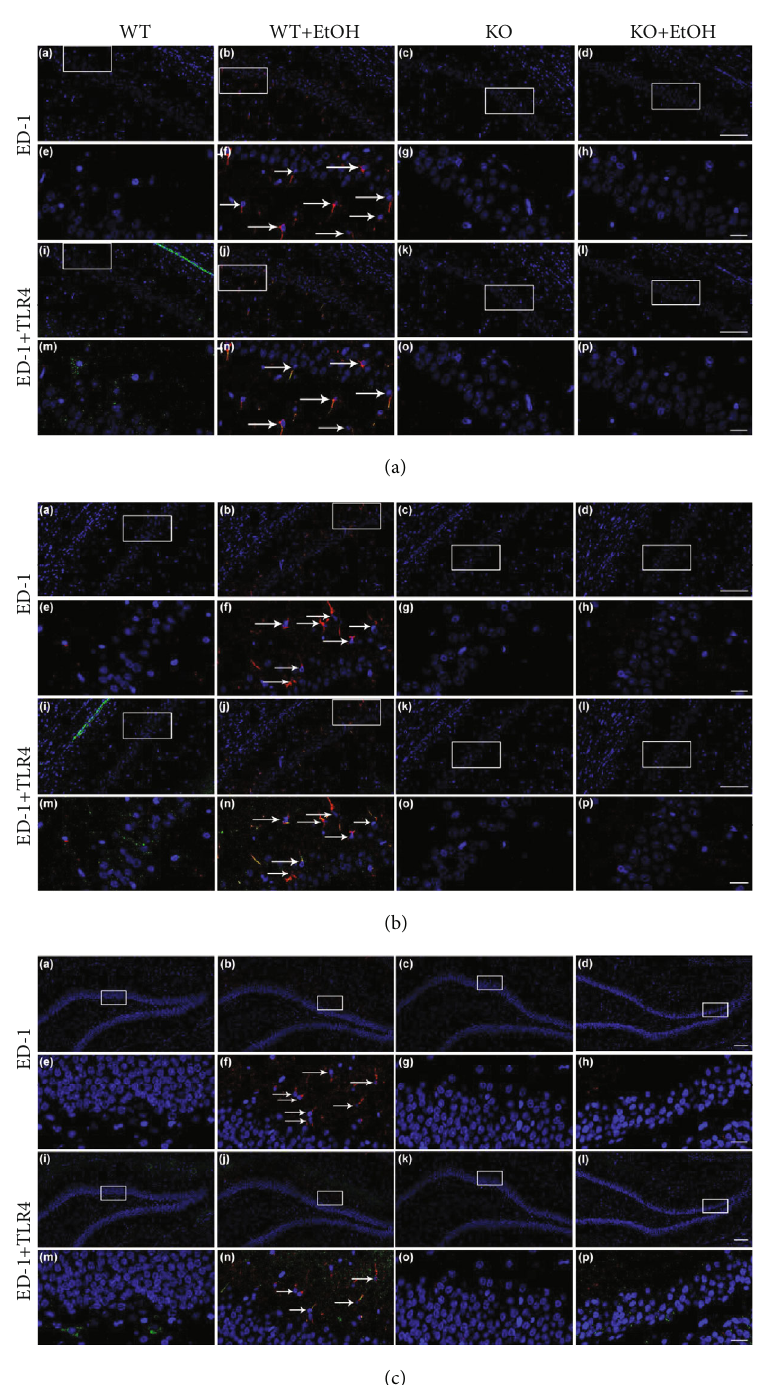
Figure 2: E ff ect of ethanol exposure on the extent of microglial activation (ED-1 staining) and colocalization of ED-1 with TLR4 (ED-1/TLR4 colabeling) in the hippocampus. Representative photomicrographs of level-matched coronal sections of CA1 (a, A – P), CA2/3 (b, A – P), and DG (c, A – P) from WT (A, E, I, M), WT+EtOH (B, F, J, N), KO (C, J, K, O), and KO+EtOH (D, H, L, P) rats. White arrows indicate ED-1 + (F) or ED-1 + /TLR4 + (N) cells. Regions of interest (framed areas) in A – D are presented in E – H for ED-1 staining and in I – L are presented in M –